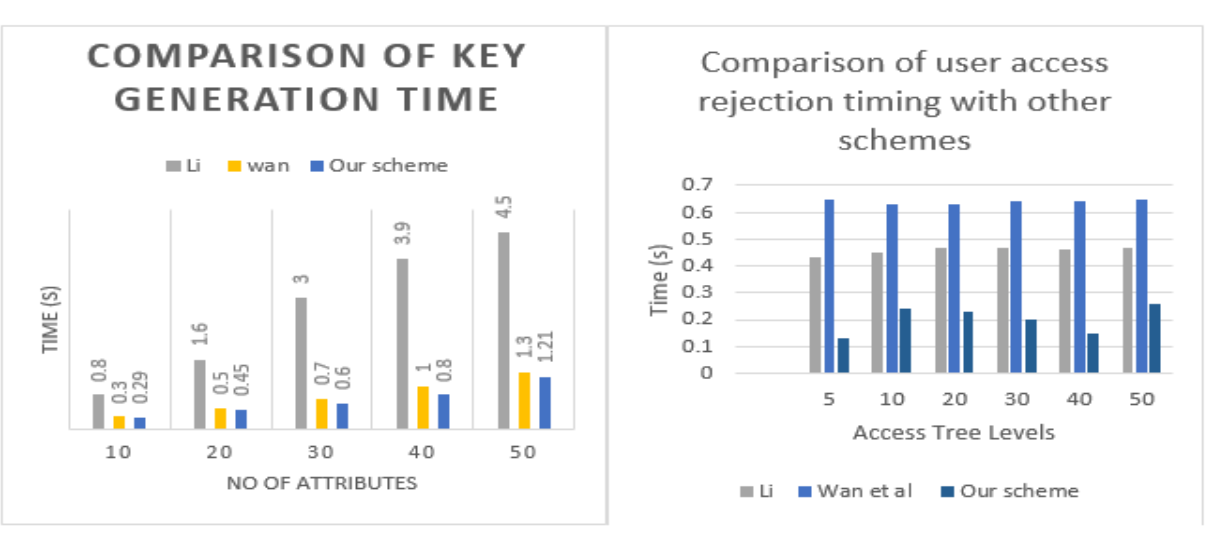
Figure 5. Comparison of key generation time and user access rejection time with other